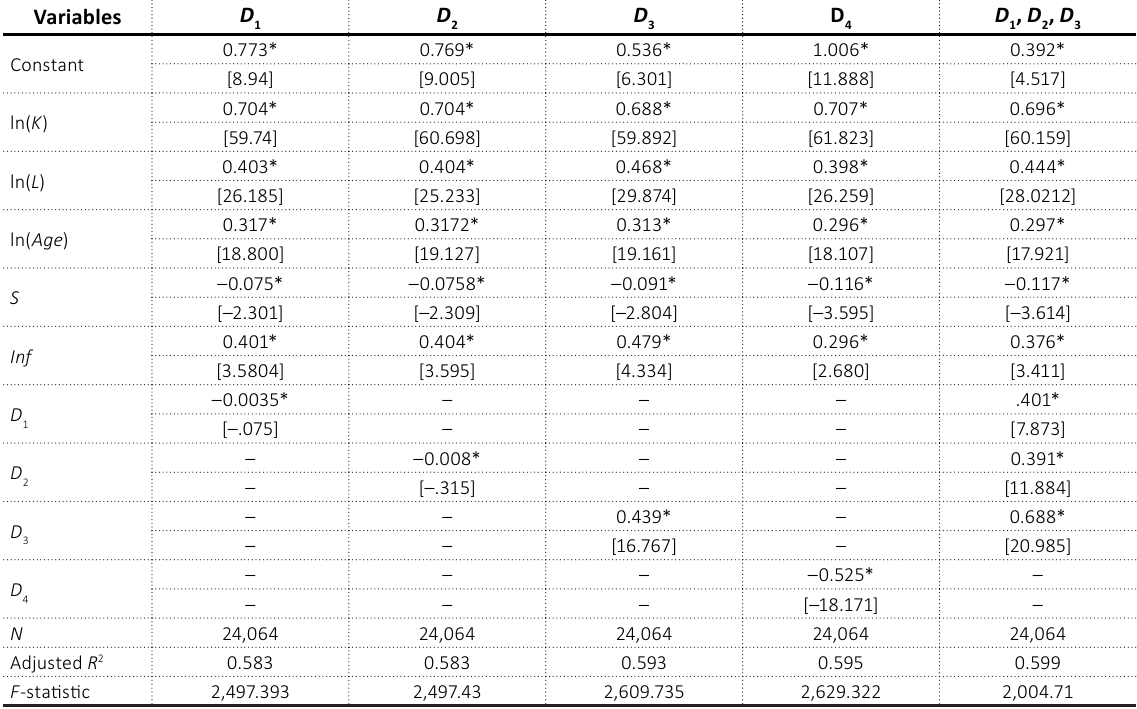
Table 1. Final estimation result of model (2) with different dummy variables